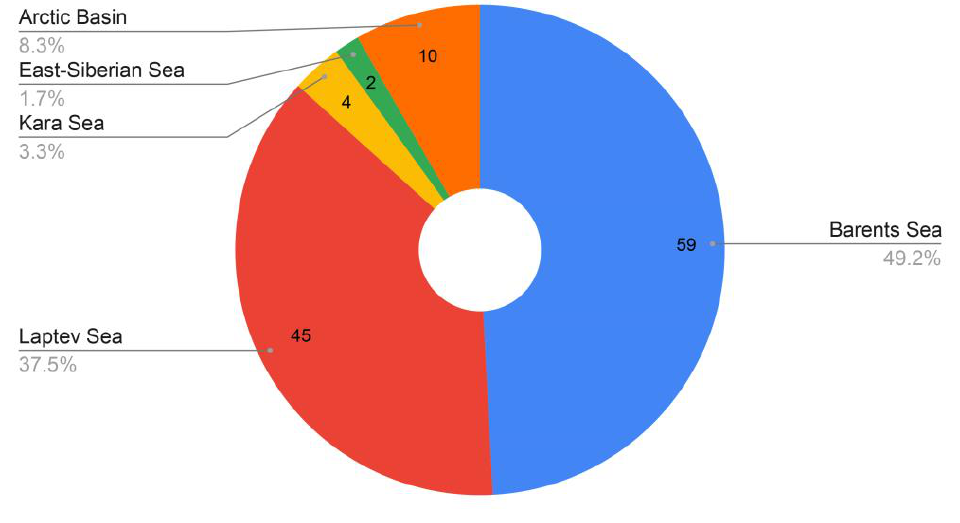
Figure 3. Distribution of siboglinid records by seas.